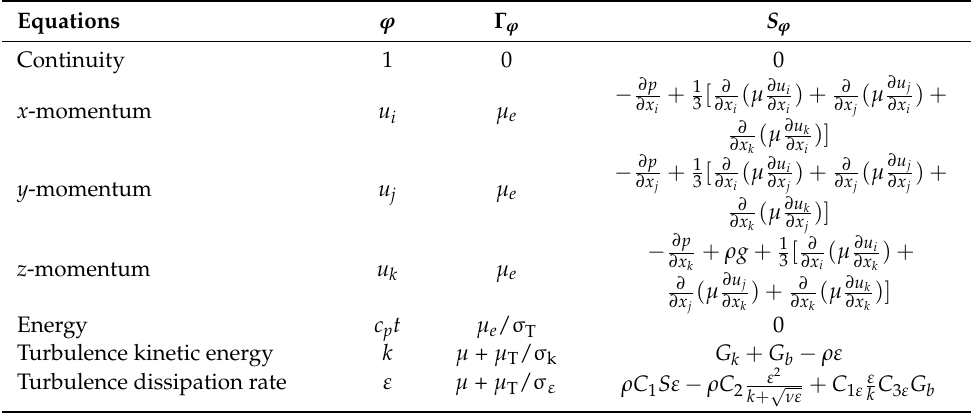
Table 2. Summary of the parameters in the governing